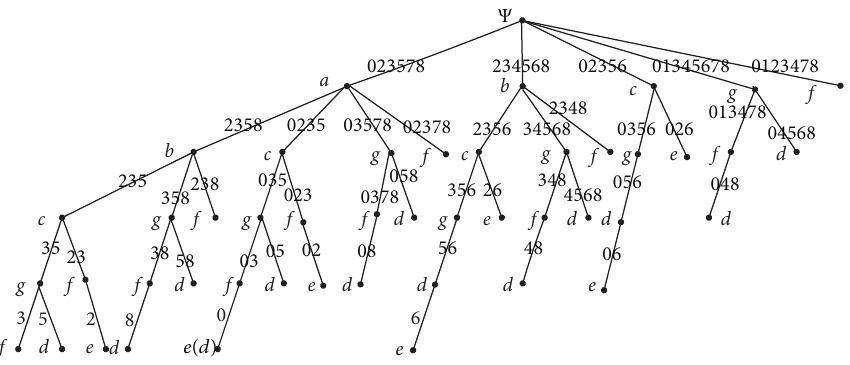
Figure 12: The path traversal tree of the attribute topology presented in Figure 2.